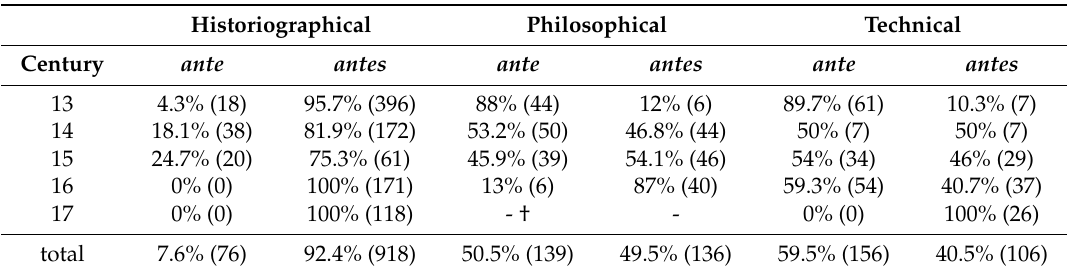
Table 2. Frequencies of ante and antes per century and per text